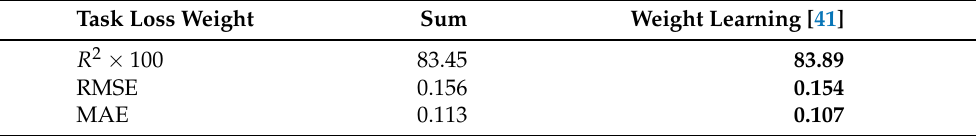
Table 6. Chl-a estimation scores of the proposed multitask model across 10-fold cross-validation with two task loss weighting schemes: direct sum and the weighting learned by the model during training, with the best results in